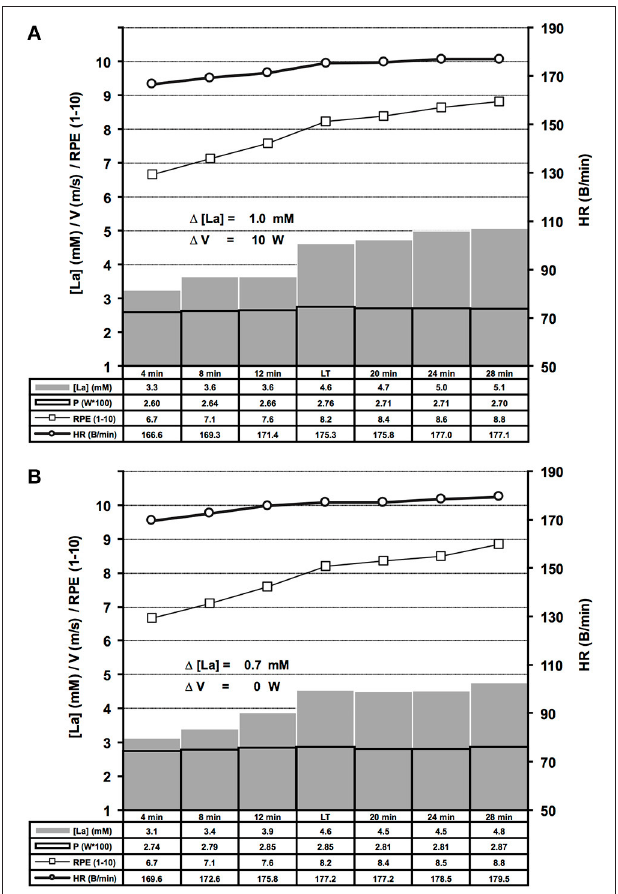
FIGURE 6 | Summary of bicycle ergometer ILT-Tests which met threshold criterion 1 ( A , n = 69) or 2 ( B , n = 79). Group mean values are shown for arterial lactate concentration [La] (mM), velocity (m/s), heart rate (B/min) and RPE (1–10). Note the steep [La] increase at the lactate threshold (LT) in response to a slight increase of cycling power. (A) Threshold criterion 1, 1 [La] = 1.0 ± 0.48mM, 1 W = 10 ± 1.58W; (B) Threshold criterion 2, 1 [La] = 0.7 ± 0.29mM. V, treadmill velocity.